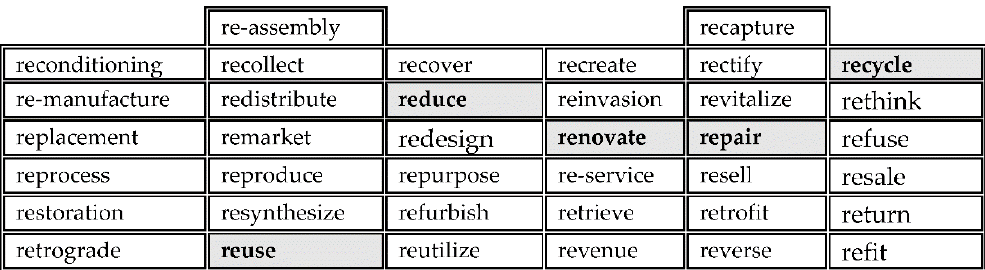
Figure 3. “R-house”, representing various aspects of the concept of circular economy. Legend: shaded blocs belong to the 5R paradigm of circular economy [61]. Source: designed by the authors based on [61] (p. 1). Table 2. The analysis of some definitions of the circular economy. Aims of Creating CE Pl/SC Levels/Nodes of an Industrial-Marketing